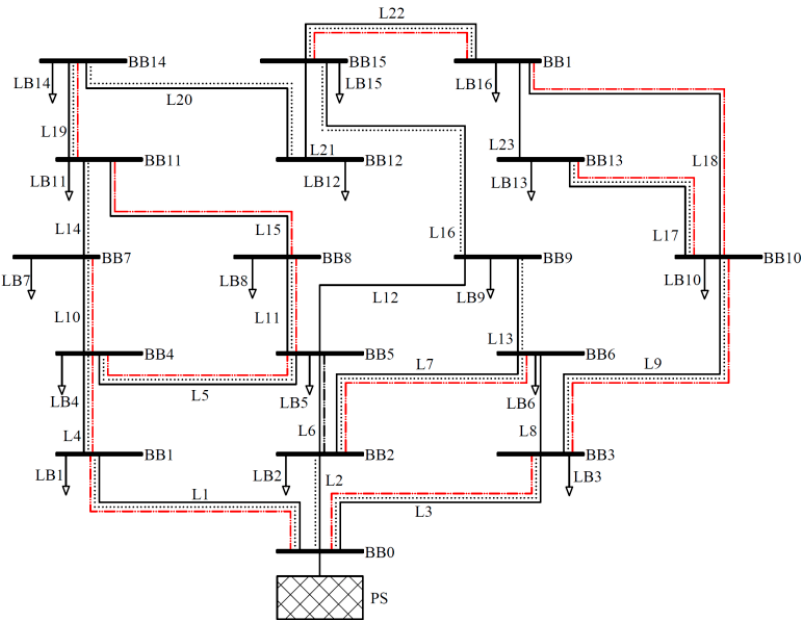
Figure 7. Power system benchmark topology (solid line) with simulation results for p = 1 (dotted line) and for p = 0.95 (red dash-dotted line).